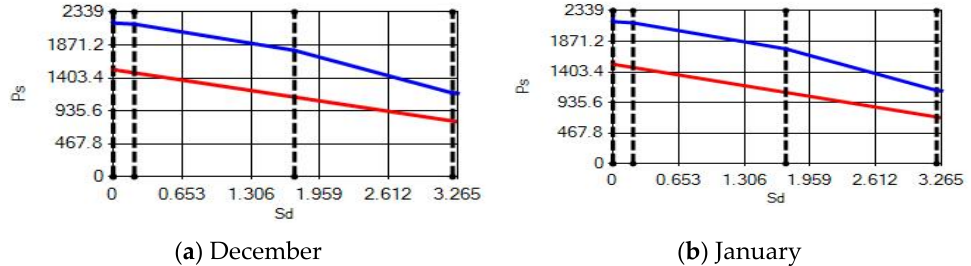
Figure 15. Condensation and evaporation amount chart for the building elements of the AAC external wall for the 2nd zone for ( a ) December and ( b ) January.